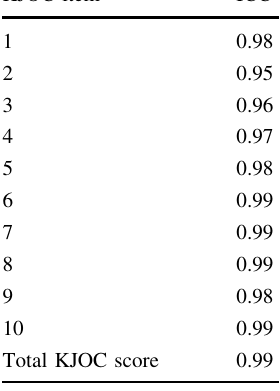
Table 3 Interclass correlation coefficients (ICC) of the ten items and of the total Kerlan– Jobe Orthopaedic Clinic Shoulder and Elbow score in 90 overhead athletes